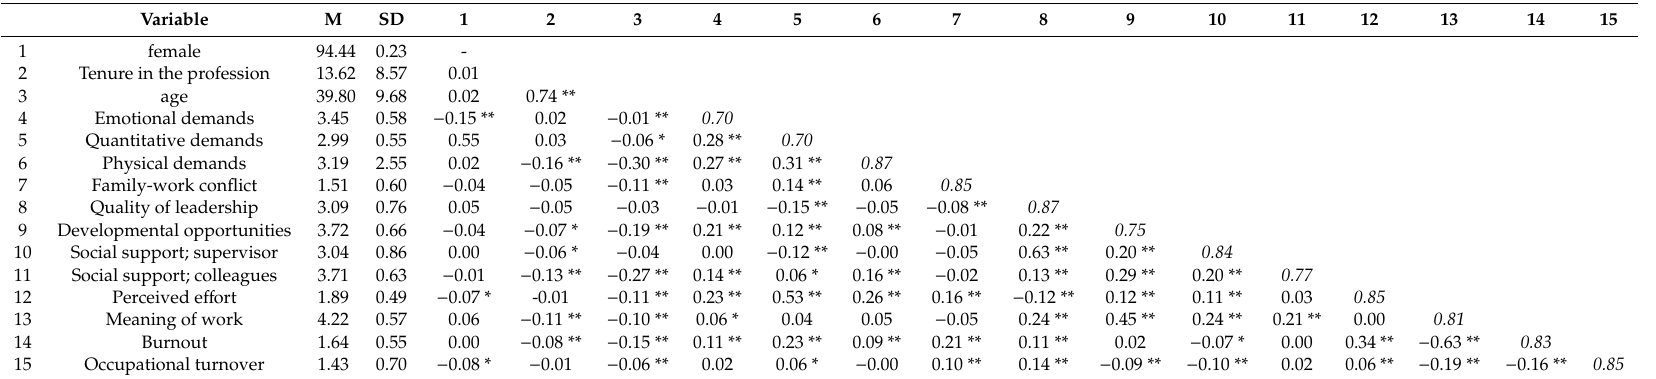
Table 1. Means, Standard Deviations, Reliability Coe ffi cients (Cronbach’s alpha; on the diagonal), and Correlations Between the Model Variables, N =